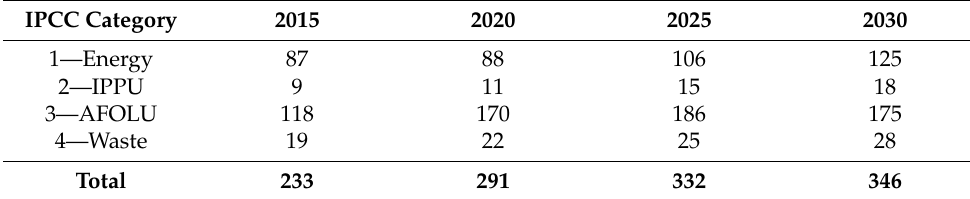
Table 12. GHG emissions results by IPCC category in reference scenario in MtCO 2 eq.